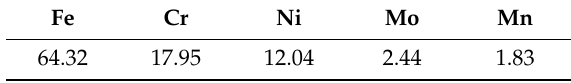
Figure 1. Microscopic morphology of the 316L stainless steel powders. Table 1. Composition of the 316L stainless steel powder (wt.%).